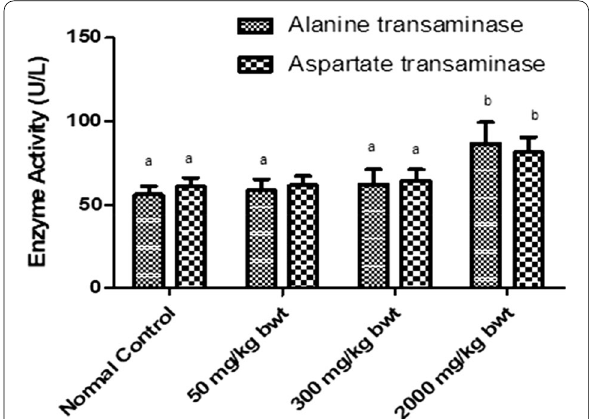
Fig. 6 Serum Alanine transaminase and Aspartate transaminase Activities in Control and Treatment Groups. Values are expressed as mean S.D ( n 5). Means of bars with different Tukey superscripts ± = are statistically significant at p < 0.05